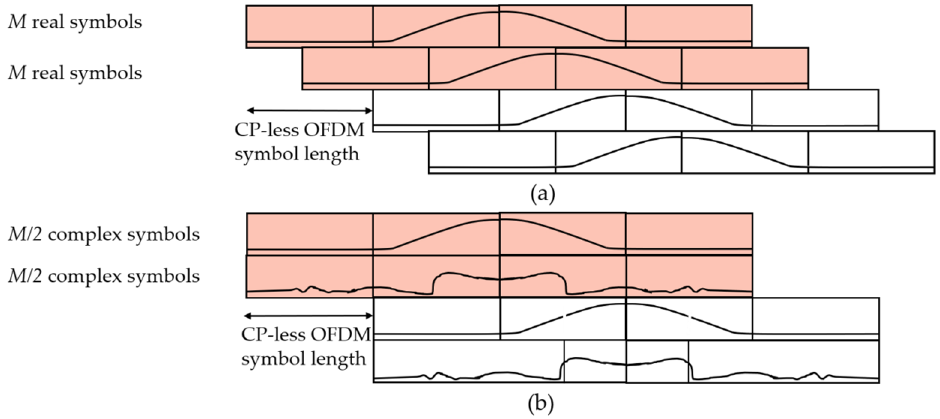
Figure 3. Comparison of time and frequency representations between FBMC ‐ OQAM and FBMC ‐ QAM waveforms: ( a ) FBMC ‐ OQAM; ( b ) FBMC ‐ QAM.